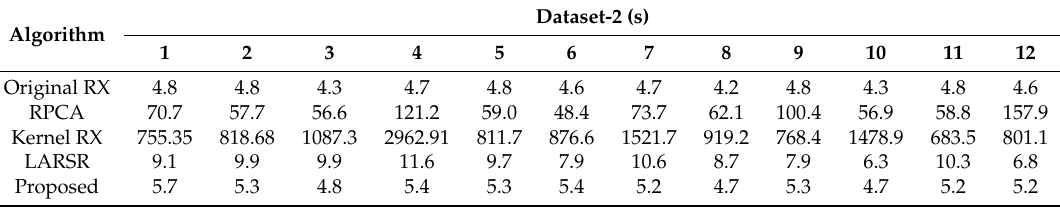
Table 7. Time consumption performances each patches in